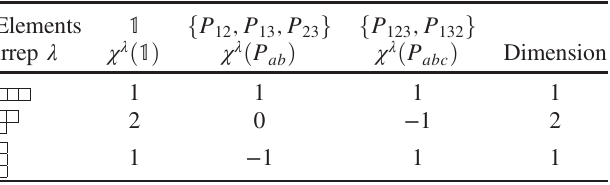
TABLE I. The character table for S 3 .